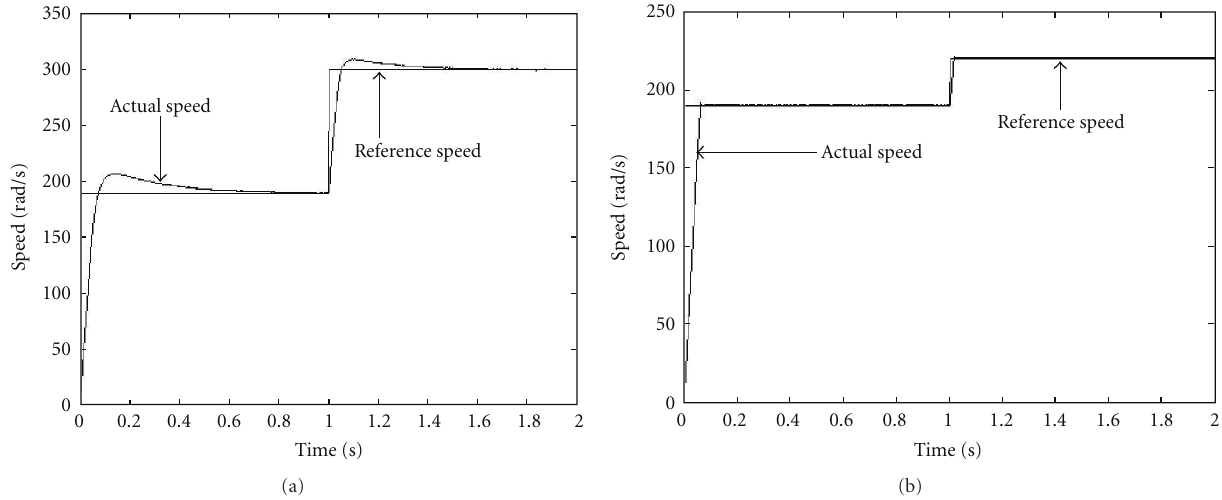
Figure 7: (a) Simulated speed of IPMSM drive for flux-weakening control due to step change of reference speed using PI controller. (b) Simulated speed of IPMSM drive for flux-weakening control due to step change of reference speed using fuzzy controller.